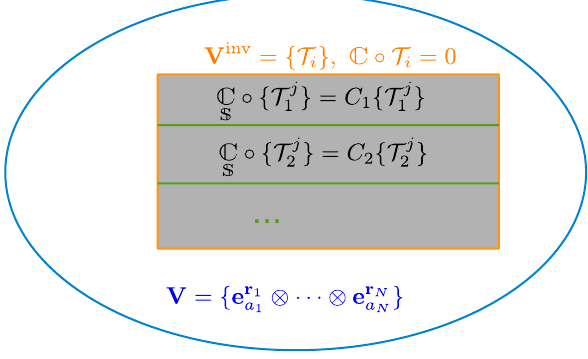
Figure 10 . A pictorial demonstration of our gauge basis and gauge j-basis in the space of the direct product representations. The blue circle represents the whole space of the direct product representation. The orange box represents the space of gauge invariant tensors spanned by our gauge basis, which is also the null space of the full Casimir operators V inv . Since the partial Casimir and the full Casimir commute, one can further divide the V inv according to the eigenvalue of C , which results in our gauge S